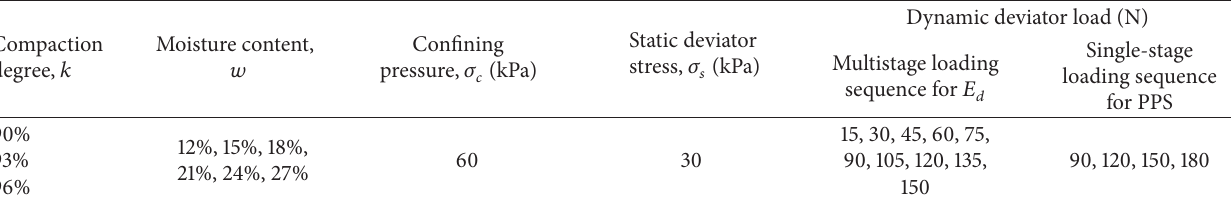
Table 2: Parameters for 𝐸 𝑑 and PPS